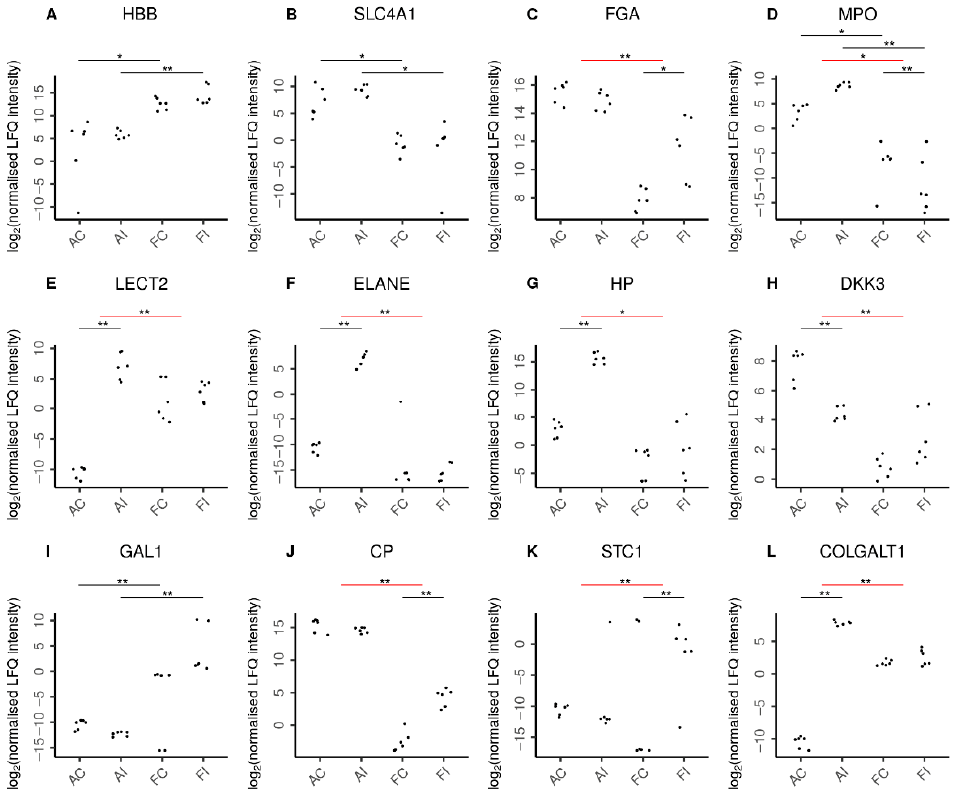
Figure 7. Selected proteins indicating characteristic features in adult and fetal animal samples. Log 2 normalized LFQ intensities of each protein are shown for adult control (AC), adult injured (AI), fetal control (FC), and fetal injured (FI) tendon samples. The pairwise comparisons discussed are indicated by horizontal bars. Comparisons can be between two samples directly (black bars) or between the adult and fetal responses to injury (red bars). Statistical significance is then shown by double asterisks (**) and marginal statistical significance by a single asterisk (*). In line with expectations, ( A ) higher amounts of hemoglobin fetal subunit beta (HBB) were seen in fetal samples. Similarly, ( B ) higher levels of solute carrier family 4 member 1 (SLC4A1) reflected the increased presence of erythrocytes in adult samples. Remarkably, ( C ) fibrinogen chain alpha (FGA) was specifically increased only in fetal injury. Adults featured a higher presence of neutrophils ( D ) as reflected by myeloperoxidase (MPO) levels in these tissues. Moreover, the adult-specific response to injury was characterized by chemoattraction of neutrophils ( E ) as indicated by leukocyte cell- derived chemotaxin 2 (LECT2) and the secretion of antimicrobial proteins ( F ) by neutrophils such as neutrophil elastase (ELANE). In addition, the adult-specific response to injury featured up-regulation of pro-inflammatory proteins ( G ) such as the acute phase haptoglobin (HP) as well as the down- regulation of the anti-inflammatory ( H ) dickkopf WNT signaling pathway inhibitor-3 (DKK3). In contrast, fetal samples featured higher levels of anti-inflammatory proteins ( I ), such as galectin-1 (GAL1). Moreover, the fetal-specific response to injury featured up-regulation of anti-inflammatory proteins such as ( J ) the inflammation-resolving ceruloplasmin (CP) and ( K ) stanniocalcin-1 (STC1). The regulation of extracellular matrix proteins also played a more pronounced role in the adult response to injury with over a dozen ECM proteins specifically up-regulated in adults, as exemplified by ( L ) the collagen beta(1-O)galactosyltransferase 1 (COLGALT1). Supplementary Figure S1 shows further proteins characterizing the adult and fetal responses to